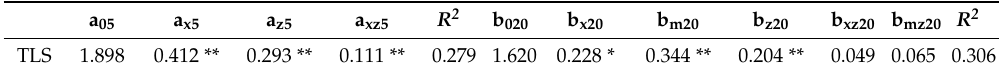
Table 6. Parameter estimation.